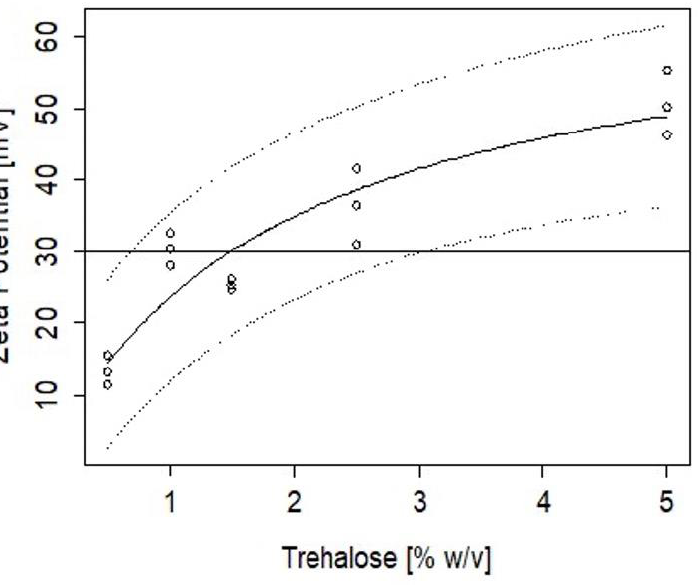
Figure 6. Zeta potential variations with added trehalose (% w / v ) where the top and bottom dash lines represent the 95% confidence Figure 6: Zeta potential variations with added trehalose (% w/v) where the top dash lines represent 95% confidence and bottom dashed line represents 50 % confidence.